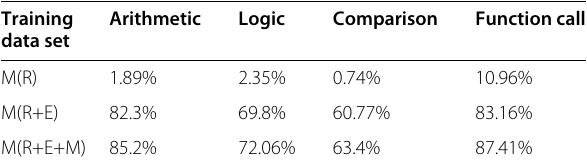
Table 2 Impact of training data augmentation Training data